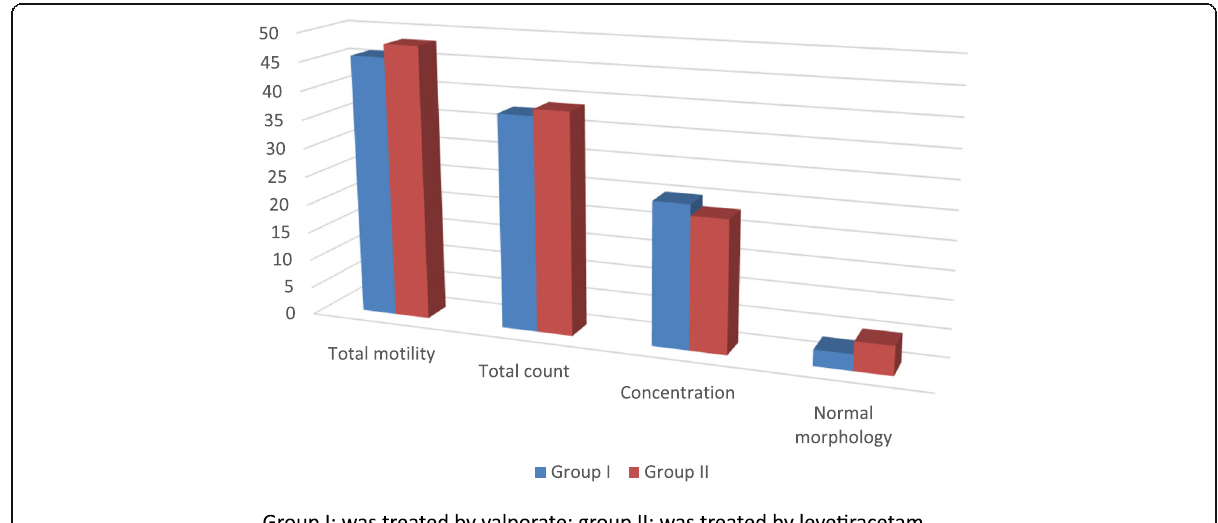
Fig. 1 Comparison between group I and group II regarding sperm parameters at post-treatment